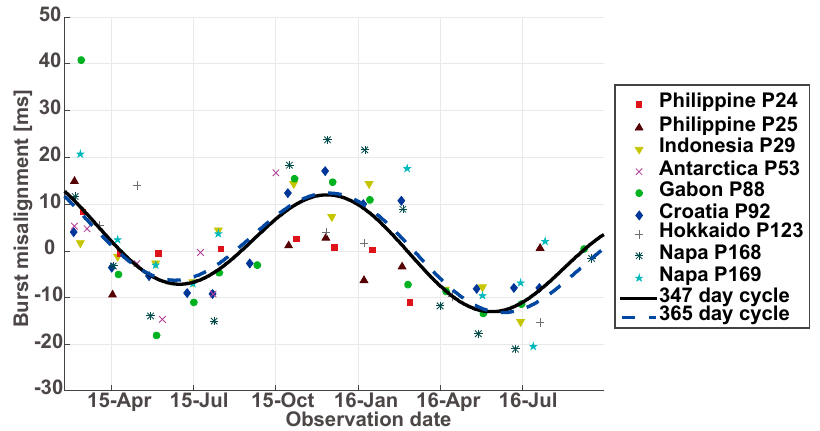
Figure 4. Time dependency of the misalignment of each path. Table 2. Misalignment record of each path in milliseconds. The average misalignment is set to zero.